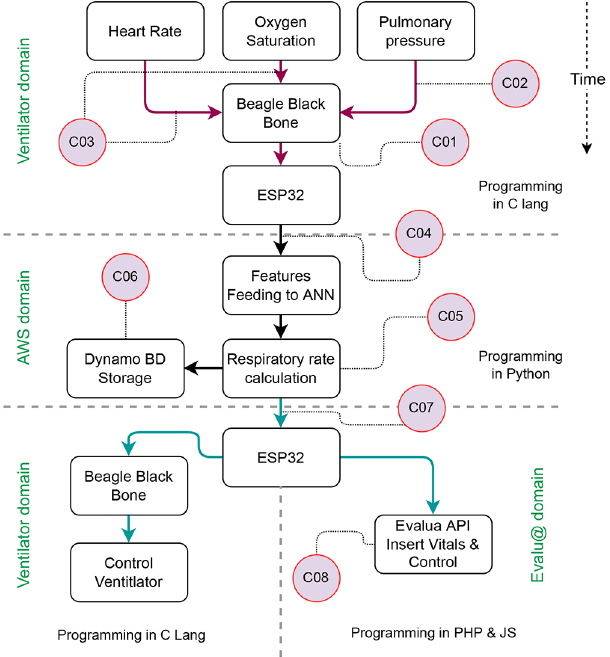
Figure8.One looprunforasingleventilator. Theroundedsymbolsrefer tocodesupporting thefunctionalitythat has been presented as complementary material to assert reproducibility.